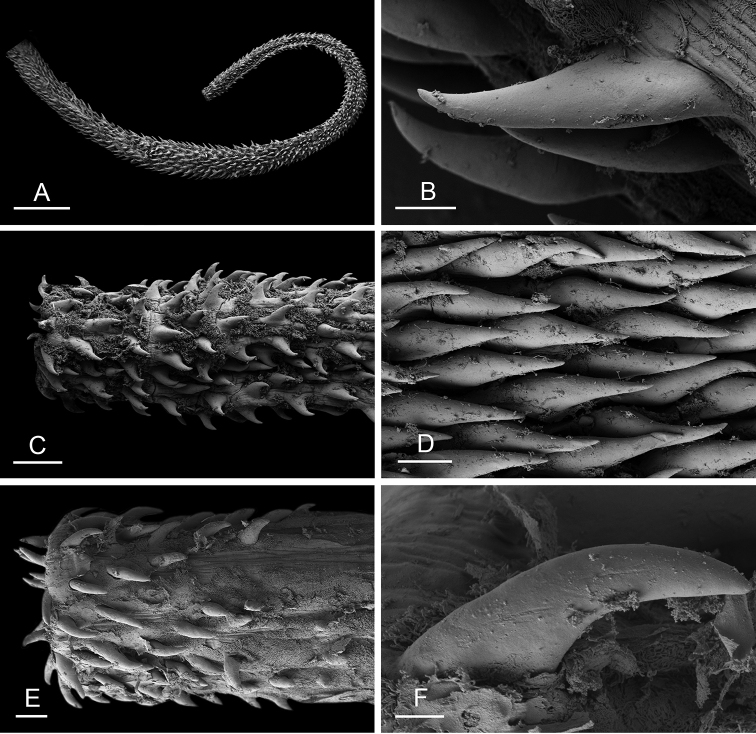
Penis and penial hooks, Peronia
verruculata, Red Sea A–C spm #1 (ZMH 27472/4) D spm #2 (ZMH 27472/4) E, F spm #4 (ZMH 27472/4). Scale bars: 300 μm (A), 10 μm (B), 30 μm (C), 20 μm (D, E), 4 μm (F).